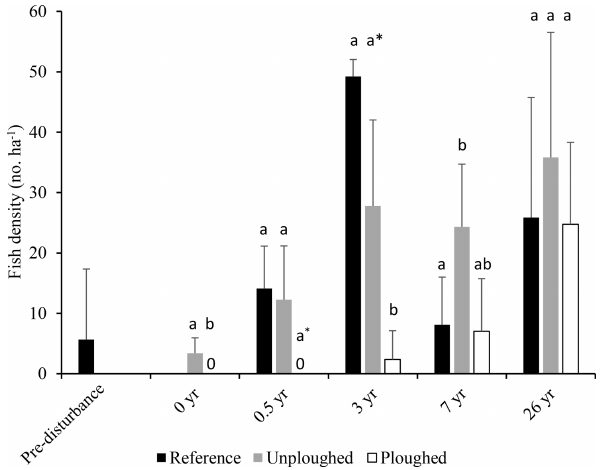
Figure 5. Fish density (in number per hectare; mean and standard deviation) from pre-disturbance (1989) to 26 years after disturbance (2015) in the reference area and in the ploughed and unploughed habitats of the DEA. Data from pre-disturbance to 7 years after disturbance are from Bluhm (2001). Letter symbols for each time indicate significant differences between habitat types ( p < 0 . 05). At 0.5 years the asterisk indicates a marginal significant difference ( p = 0 . 057).